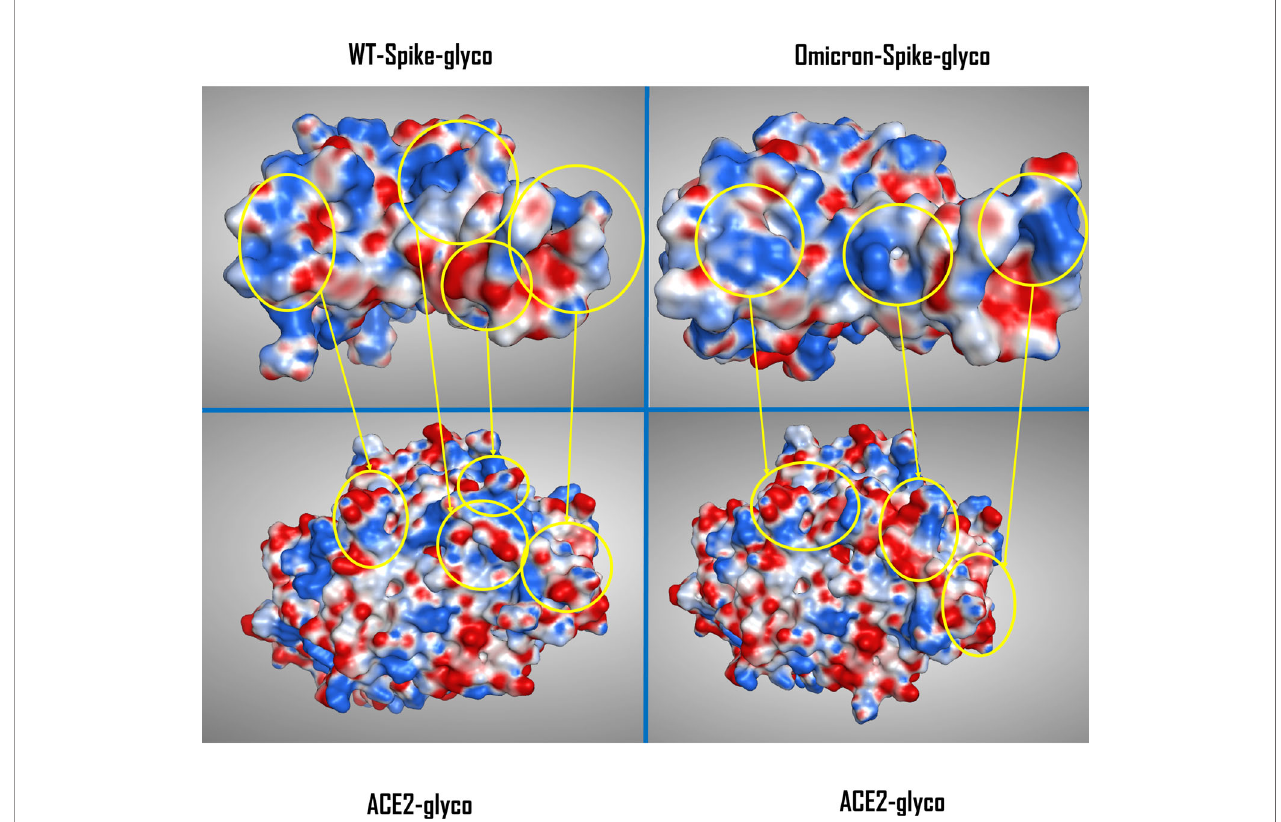
FIGURE 2 | Comparison between the electrostatic contact surface between the WT-Spike-RBD-glyco/ACE2-glyco system (top and bottom left) and the Omicron- Spike-RBD-glyco/ACE2-glyco complex (top and bottom right). The areas of highest variation in electrostatic distribution between glycated WT and Omicron Spike- RBDs are circled in yellow and are then connected with the corresponding ACE2-glyco interacting surface portion. The Spike-RBD/ACE2 backbone conformation for the WT variant comes from the crystal with PDB code 6M0J, while for the Omicron variant the data come from the Cryo-EM structure with PDB code 7T9L. WT,